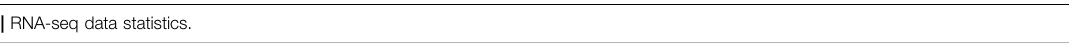
TABLE 3 | RNA-seq data